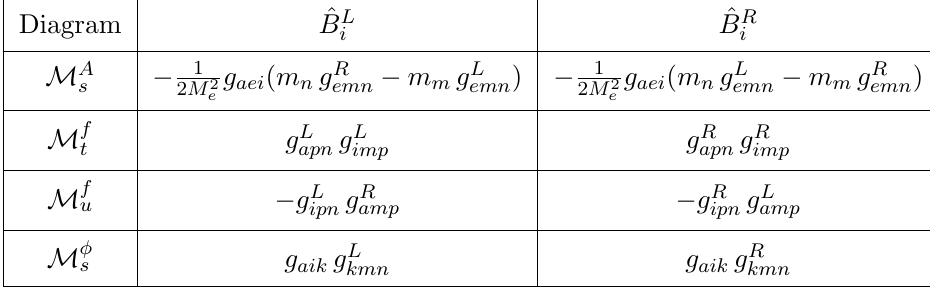
Table 4 . Coe(cid:14)cients ^ B L;R